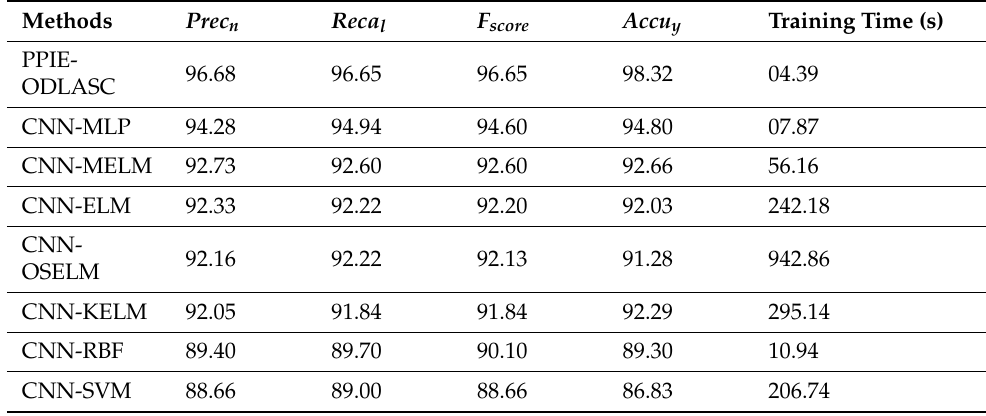
Figure 11. ROC analysis of the PPIE-ODLASC approach. Table 6. Comparative analysis of PPIE-ODLASC with other recent